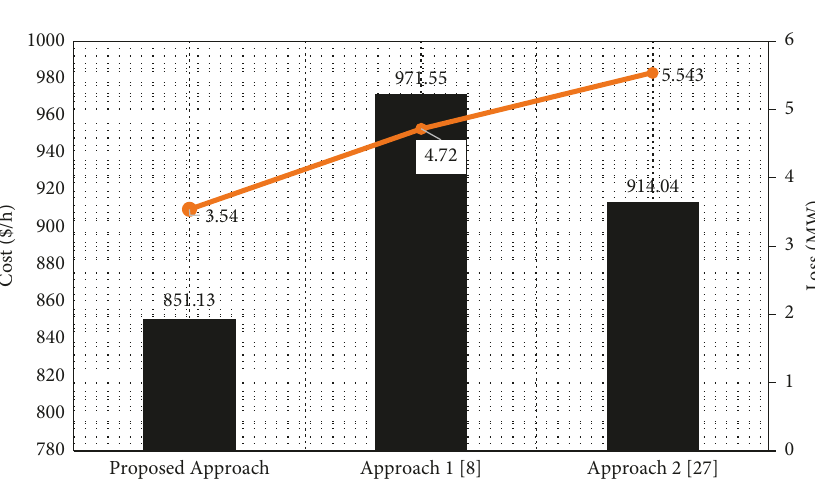
Figure 17: Comparison of the proposed approach against other